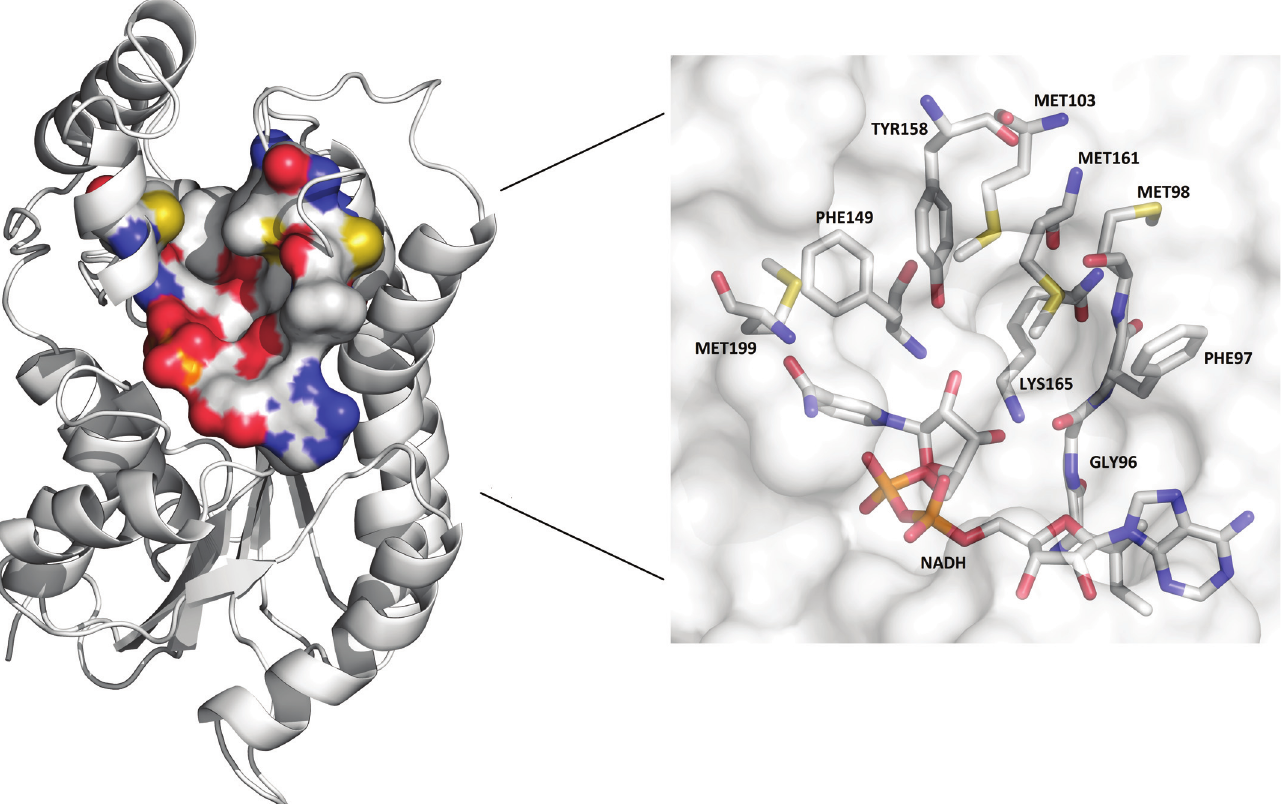
Fig 2. Substrate-binding cavity of the InhA enzyme (PDB ID: 1BVR) identified by the CASTp software tool. On the left, the substrate-binding cavity of the 1BVR structure represented by molecular surface and colored by atom types (carbon and hydrogen: light grey; nitrogen: blue; oxygen: red; sulphur: yellow). The projection displays all residues from the binding pocket in stick representation.